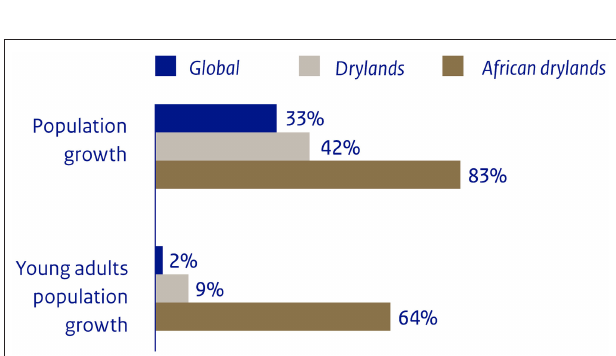
FIGURE 2 | Population growth and growth of the share of young adults in %, by 2050 compared to 2010, globally, in drylands and in the African Drylands (Figure taken with permission from Ligtvoet et al., 2018, data from Samir and Lutz, 2017).